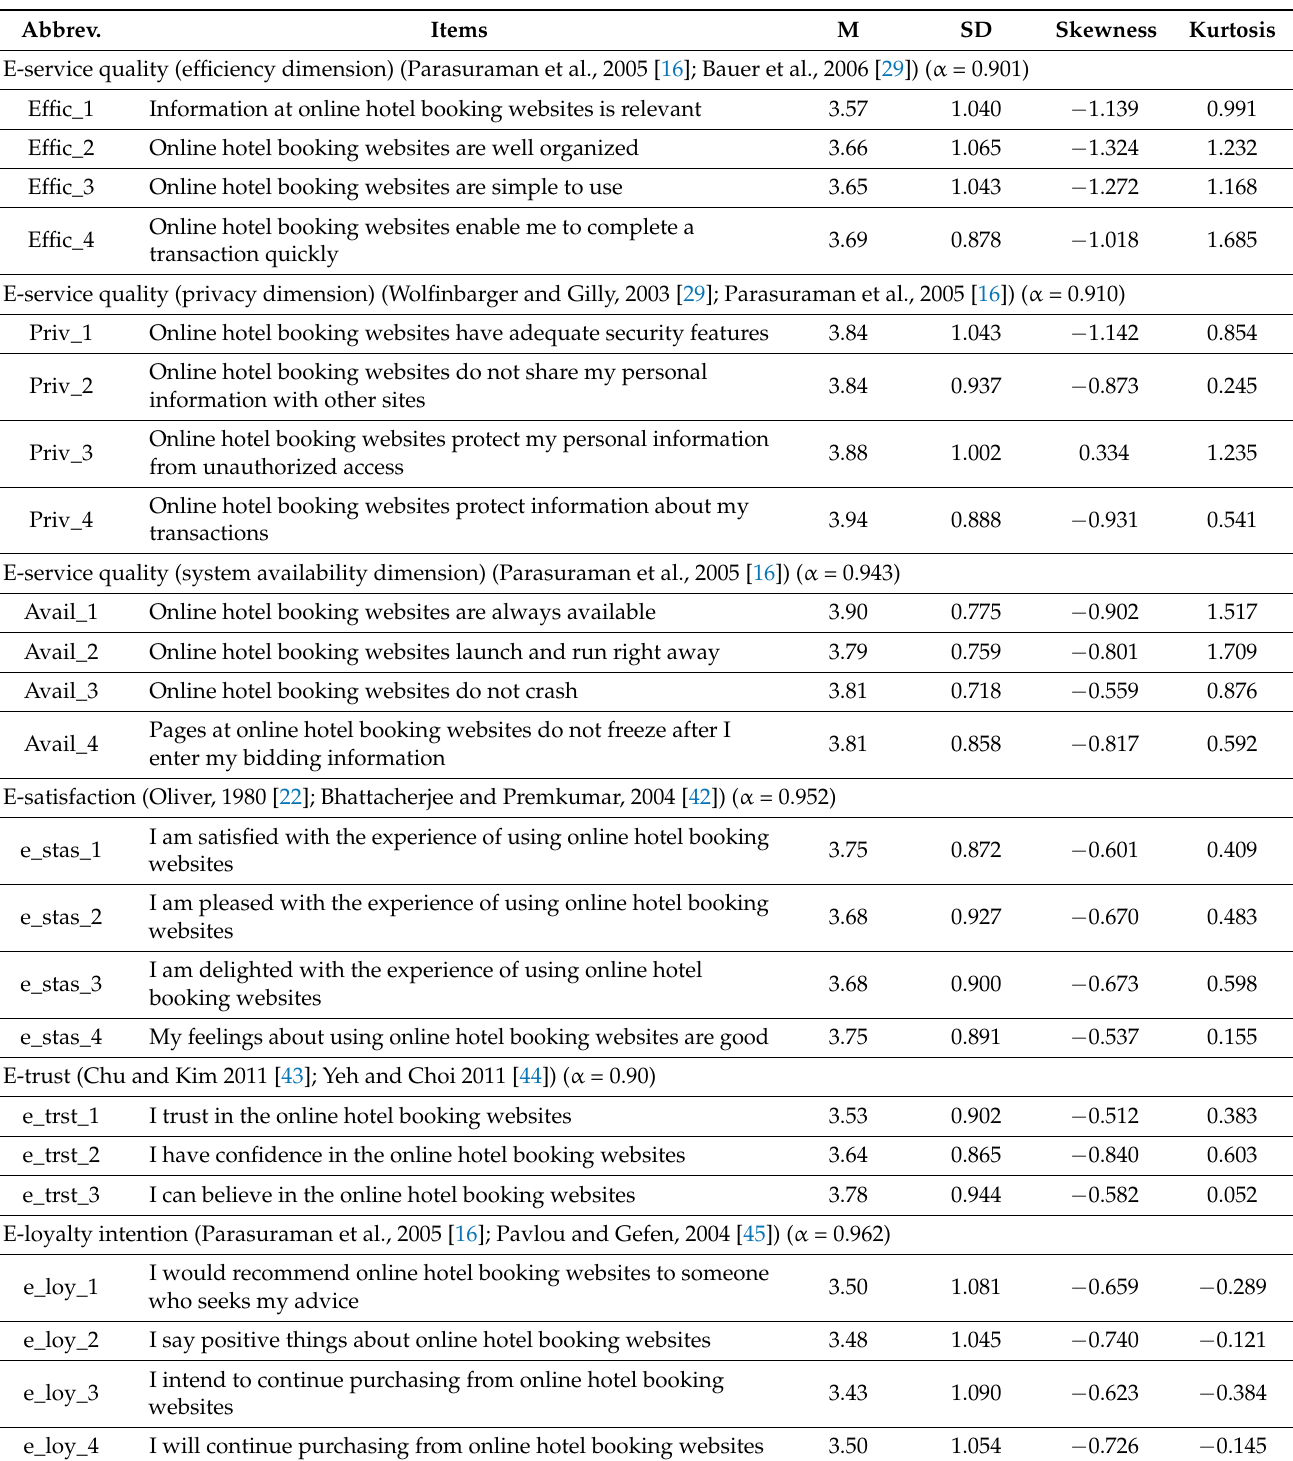
Table 1. Descriptive statistics (M, SD, skewness, and kurtosis